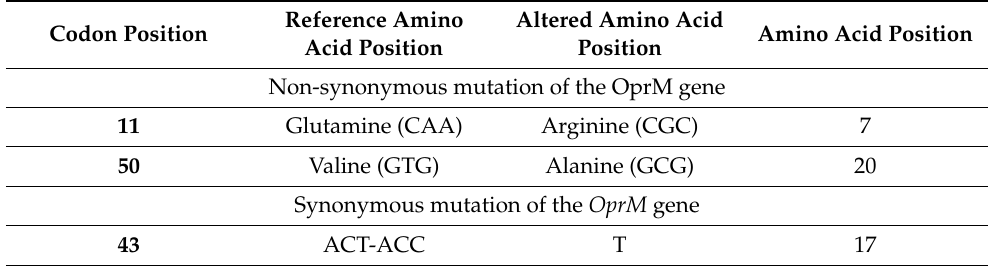
Table 11. Synonymous and non-synonymous mutations of the oprM